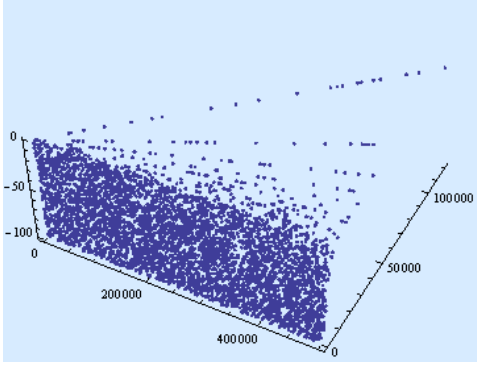
Fig. 2 Parameter Subspace of R 3 such that the origin is locally asymptotically